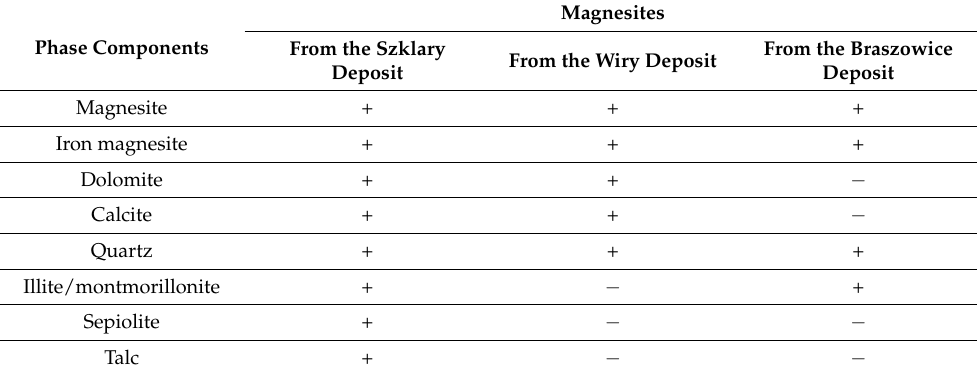
Table 3. Phase composition of the magnesites identified by diffraction analysis. Phase Components